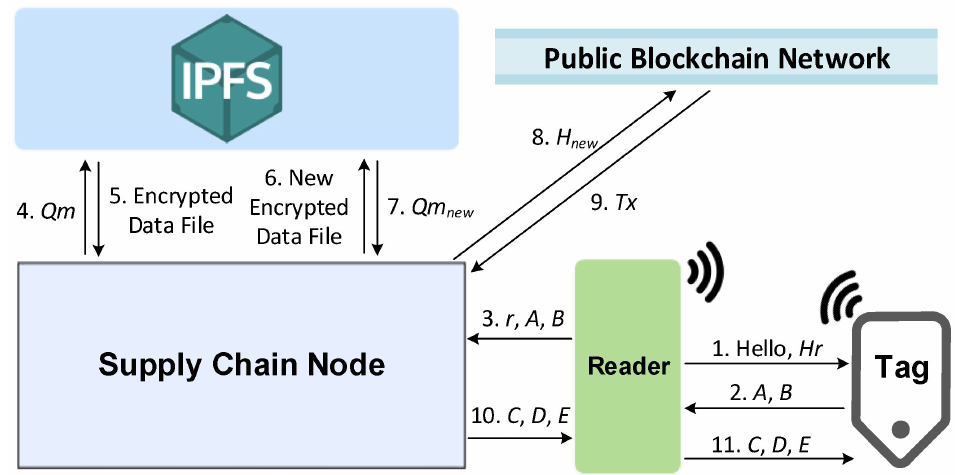
Figure 2. Authentication phase of the proposed lightweight